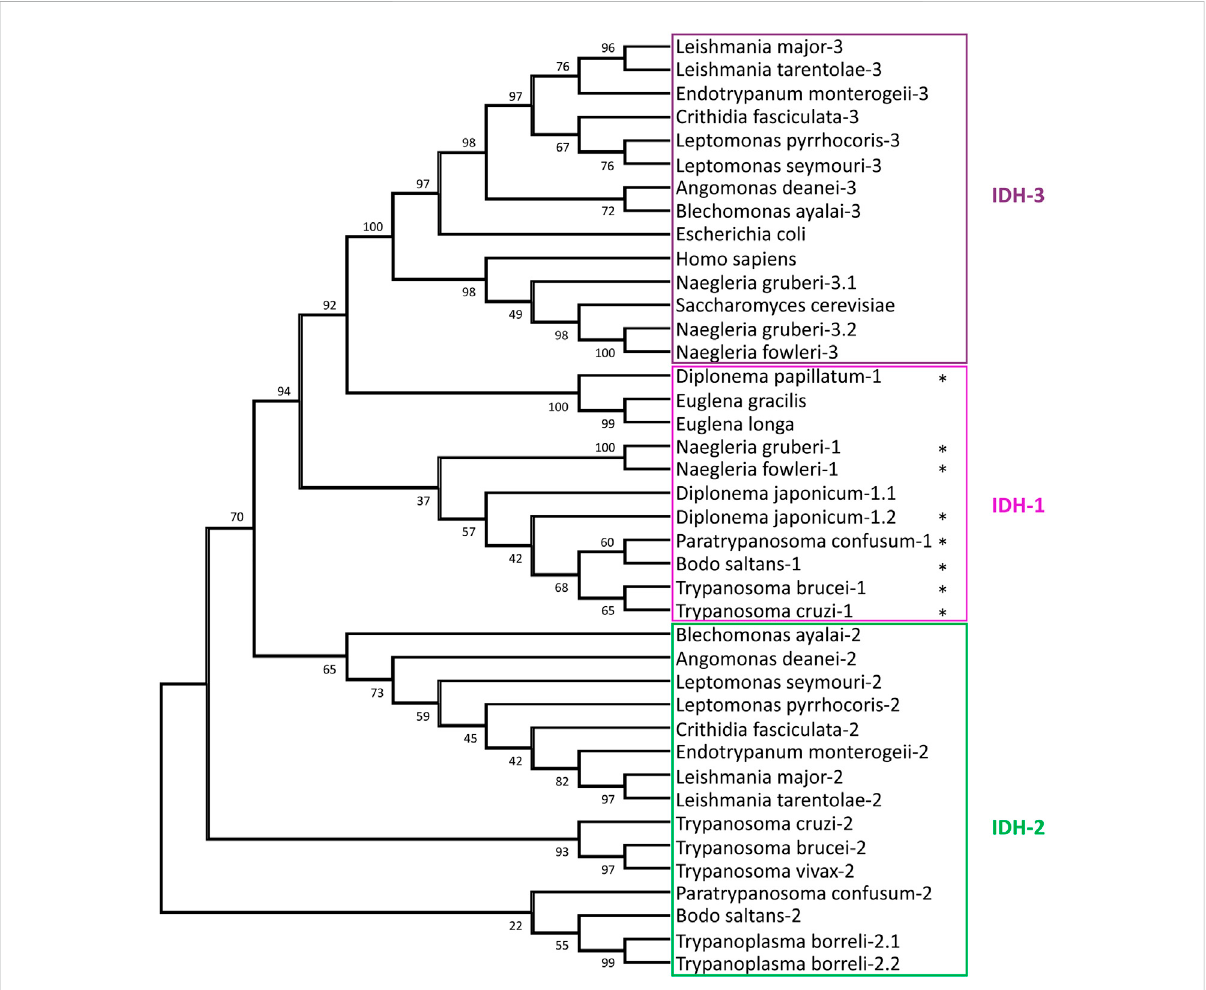
FIGURE 4 Relationships between isocitrate dehydrogenase (IDH) sequences. The evolutionary history of IDH sequences was inferred by methods describedinthelegendofFigure3.Theanalysisinvolved40amino-acidsequences,withatotalof319positionsinthe fi naldataset.Thestarsindicate sequences with a PTS1. The following IDH sequences were retrieved from the NCBI: H. sapiens , S. cerevisiae , E. coli , T. borreli , D. papillatum , D. japonicum , E. longa , and E. gracilis , whereas for Naegleria spp. the sequences were retrieved from AmoebaDB. The other euglenozoan sequences were taken from